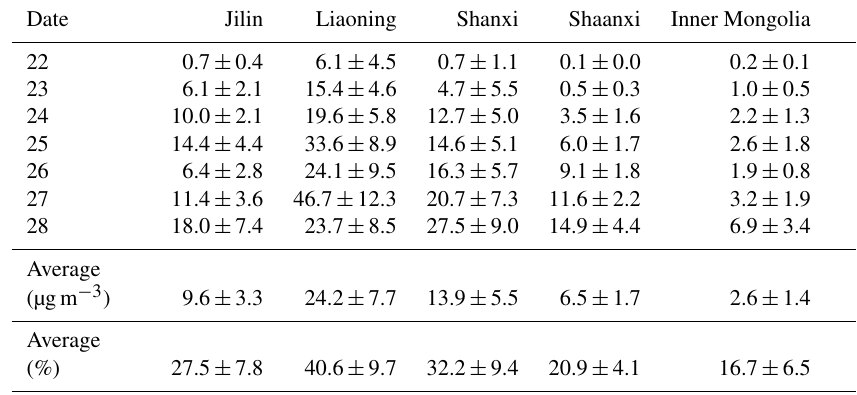
Table 2. Daily average PM 2 . 5 contributions (µgm − 3 ) of NCP emissions in NEC and NWC from 22 to 28 May 2015.